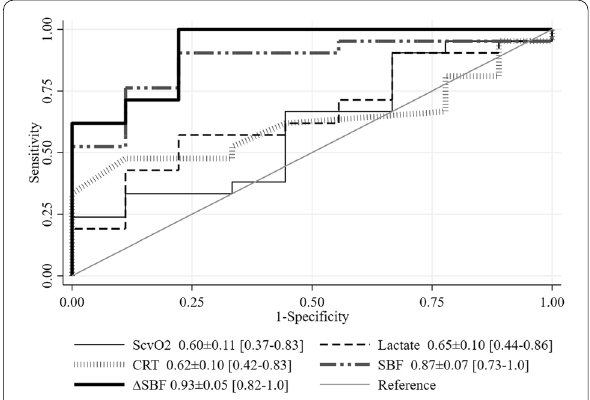
Fig. 3 Areas under the curve for prediction of change in tissue perfusion (change in lactate concentration concentration at